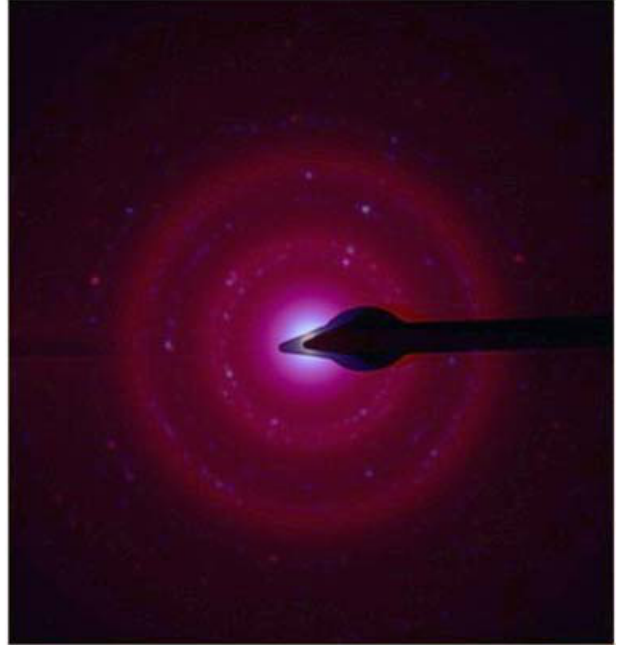
Figure 4. ED pattern of metallic gold standard solution (blue) superimposed on the experimental ED pattern obtained from Au NPs analysis (red) where the overlap indicates the DNA template prepared sample is metallic